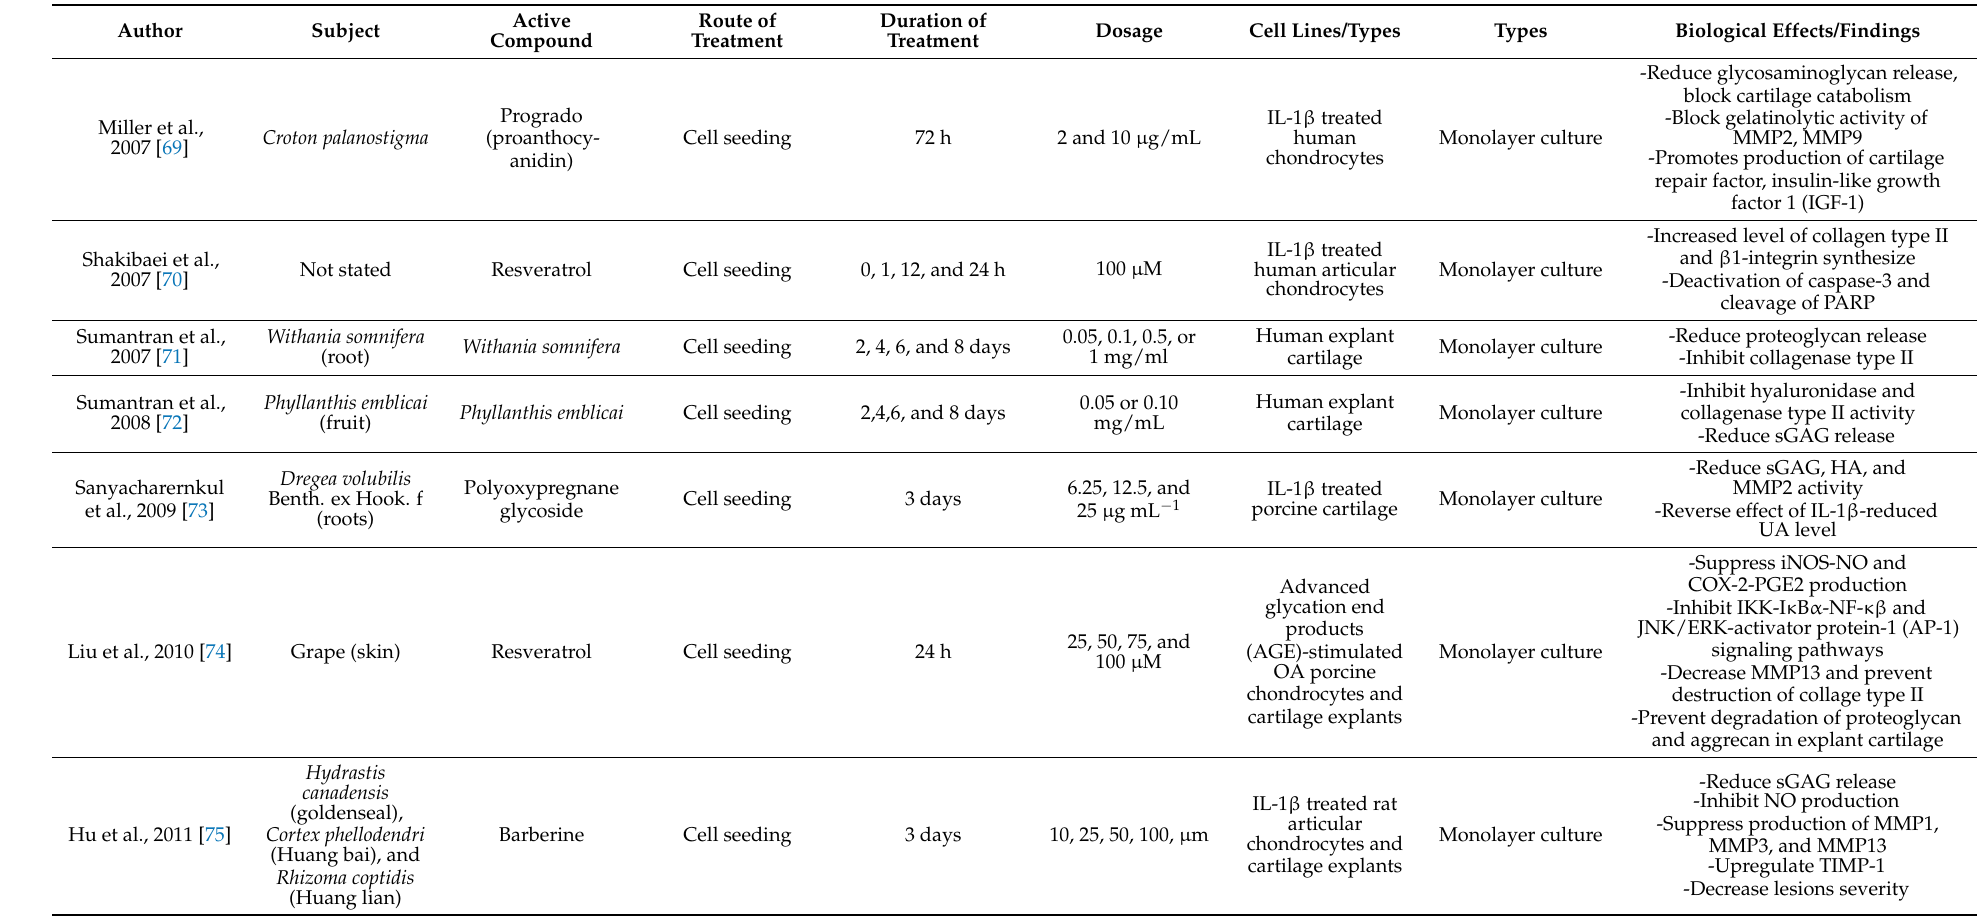
Table 1. In vitro evidence of the effects of natural compound on